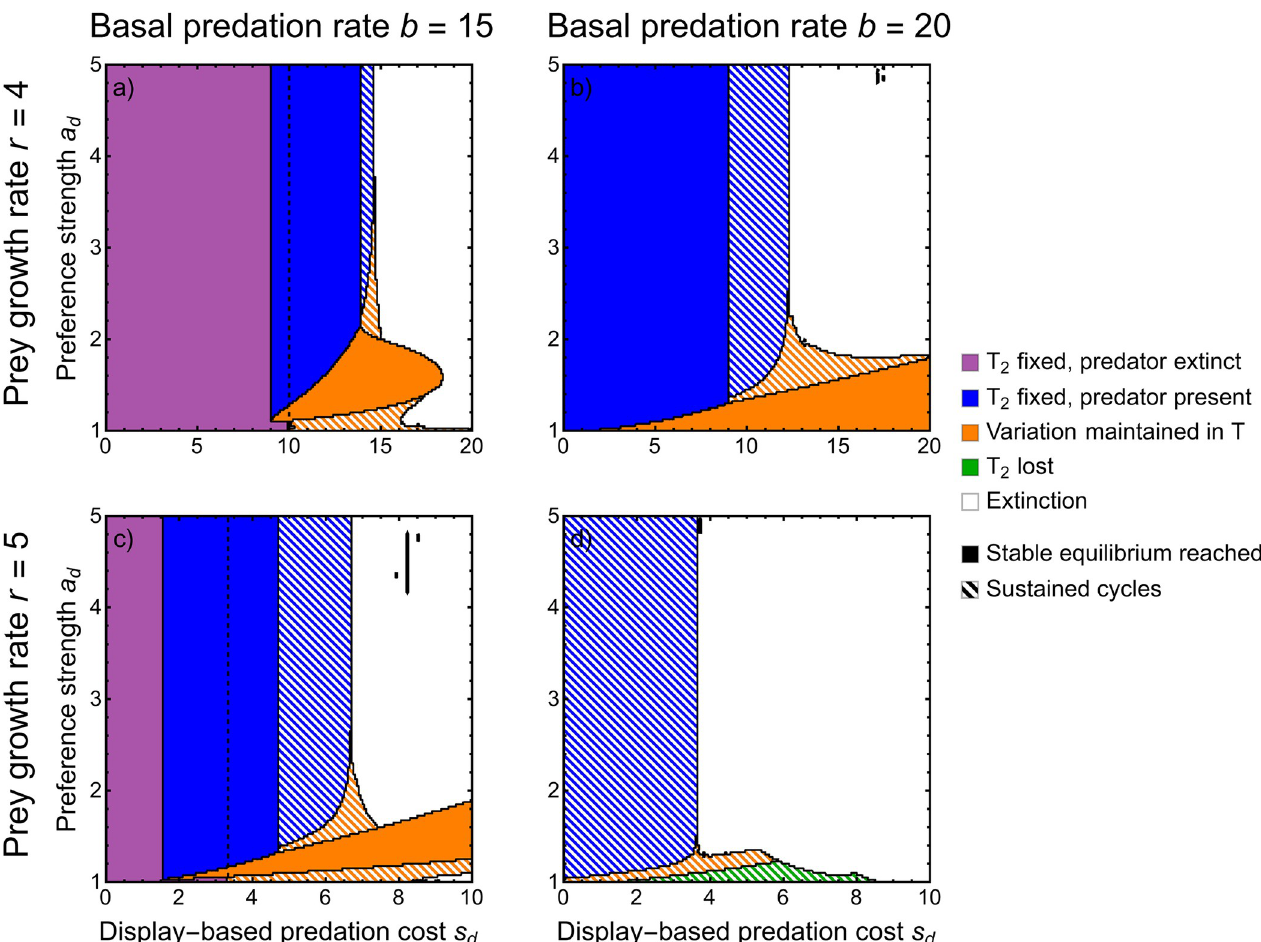
Fig 4. Eco-evolutionary outcomes from the discrete model. Horizontal axis is display-based predation cost s d , and vertical axis is preference strength a d . Each and prey growth rate r . Colors and stripes have the same meaning as in Fig 2. Striped blue and green panel represents a different basal predation rate b d d indicates only ecological cycles, whereas striped orange corresponds to eco-evolutionary cycles. White regions indicate that density becomes negative (which we interpret as extinction). If the model did remain well behaved, we believe that this region would mostly consist of eco-evolutionary cycles; however, the cycle amplitude is too large and negative densities result. The dashed black vertical line seen in some panels is the display-based predation cost below, which predator extinction is stable (thus, regions of blue or orange to the left of this line indicate bistability). Note that the scale of the horizontal axis changes across rows. c d = 0.1. This Figure can be generated using S1